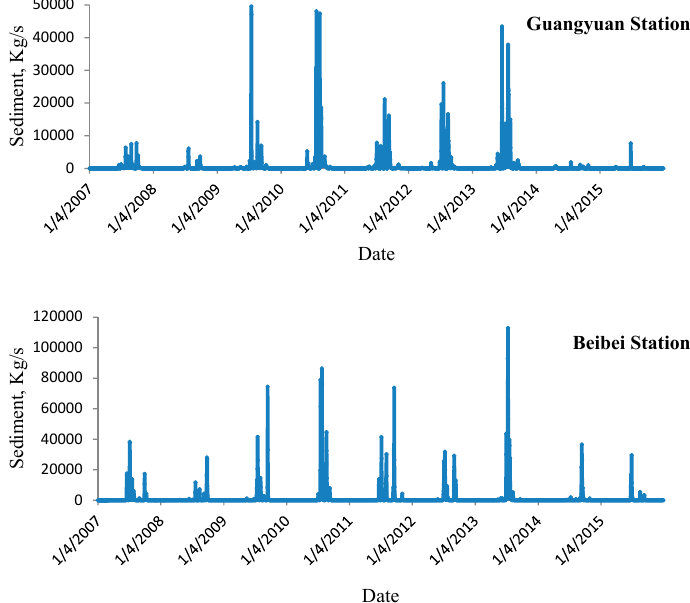
Figure 1. Time variations plot of daily sediment load of two stations during the study period.